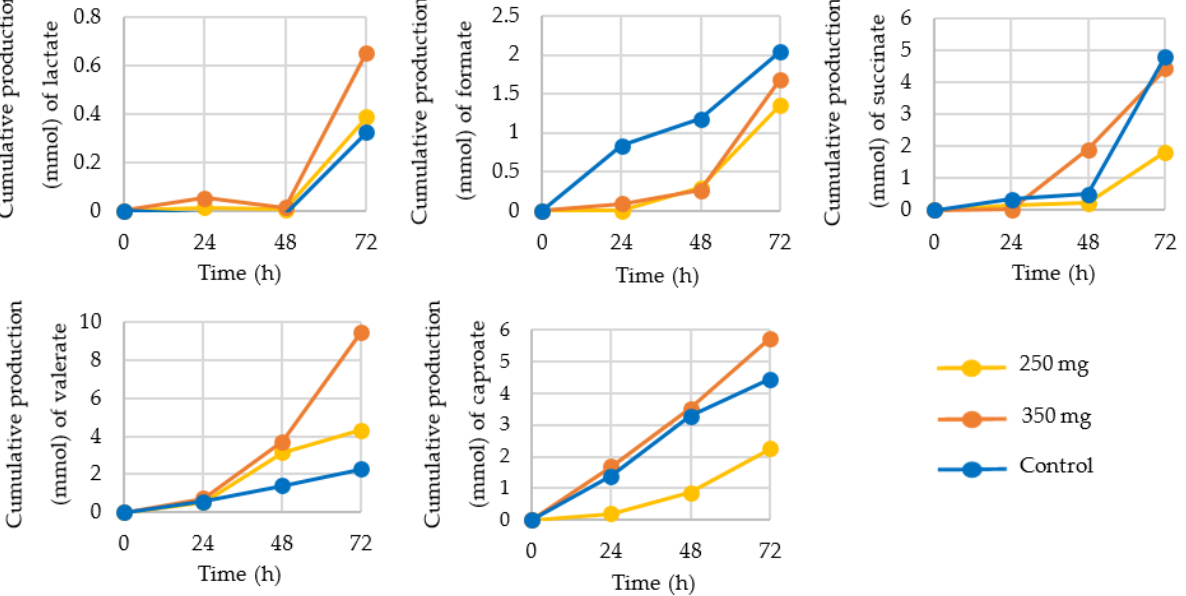
Figure 5. Cumulative production (mmol) of organic acids lactate, formate, succinate, valerate, and caproate at 24, 48, and 72 h after supplementation with 250 mg (yellow) or 350 mg (orange) Citrus Frui Extract or control (standard ileal efflux medium (SIEM; blue)).